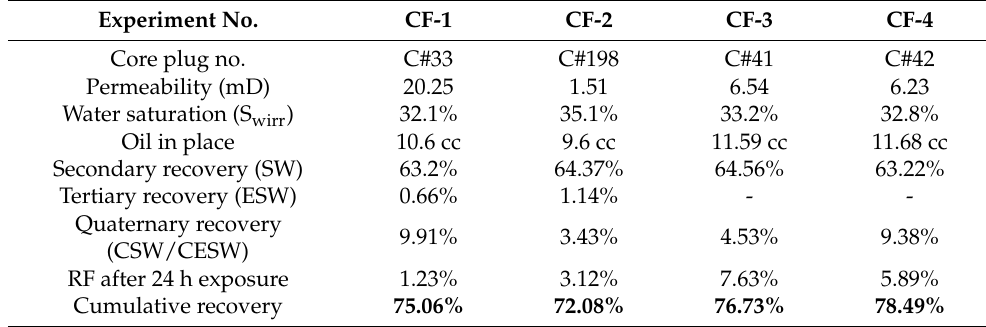
Table 5. Coreflood recovery results and